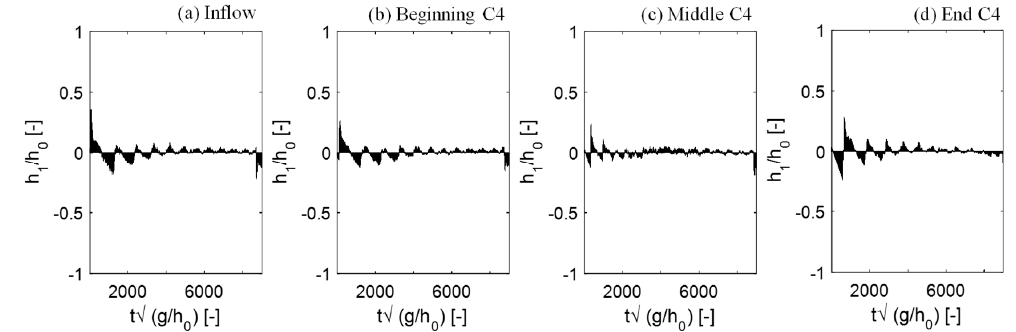
Figure 10. Deviation of measured water level ratios and time-dependent mean value ratios for the branched channel model.